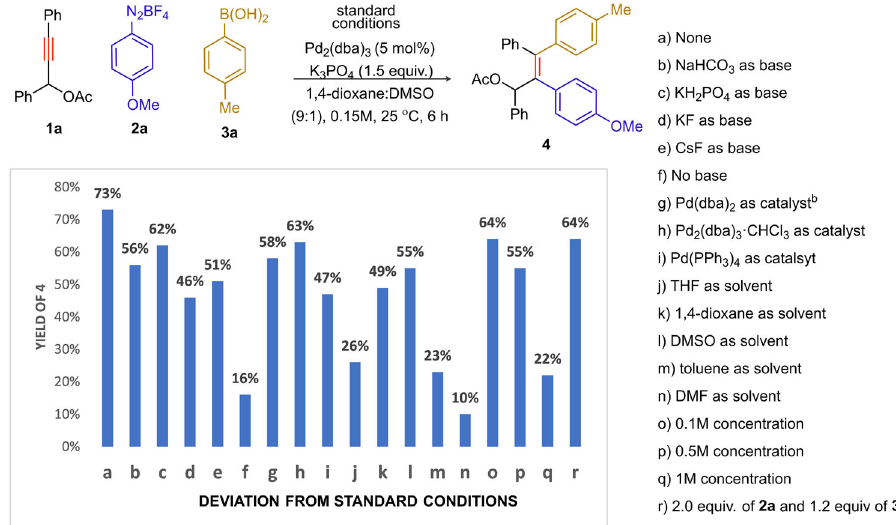
Fig. 2 Optimization of the reaction conditions a . a Isolated yield. 1a (0.2 mmol), 2a (0.6 mmol), 3a (0.3 mmol), cat. (0.01 mmol) and base (0.45 mmol). b 10